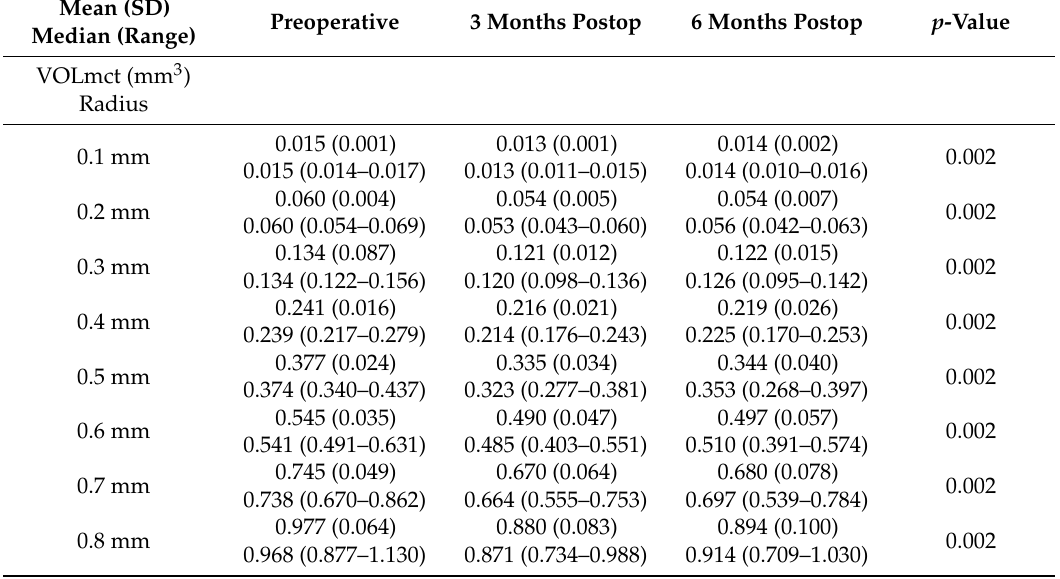
Table 3. Changes in the corneal volumetric parameters defined during the follow-up in the analyzed sample. Abbreviations: SD, standard deviation; VOL mct , volume contained in the intersection between the solid model of the cornea and a cylinder of revolution with radius × (from 0.1 to 1.5 mm) and its axis defined by the points of the minimum corneal thickness of the anterior and posterior corneal surface; VOL aap , volume contained in the intersection between the solid model of the cornea and a cylinder of revolution with radius × (from 0.1 to 1.5 mm) and its axis defined by a straight line perpendicular to the tangent plane to the anterior corneal surface at the apex; VOL pap , volume contained in the intersection between the solid model of the cornea and a cylinder of revolution with radius × (from 0.1 to 1.5 mm) and its axis defined by a straight line perpendicular to the tangent plane to the posterior corneal surface at the